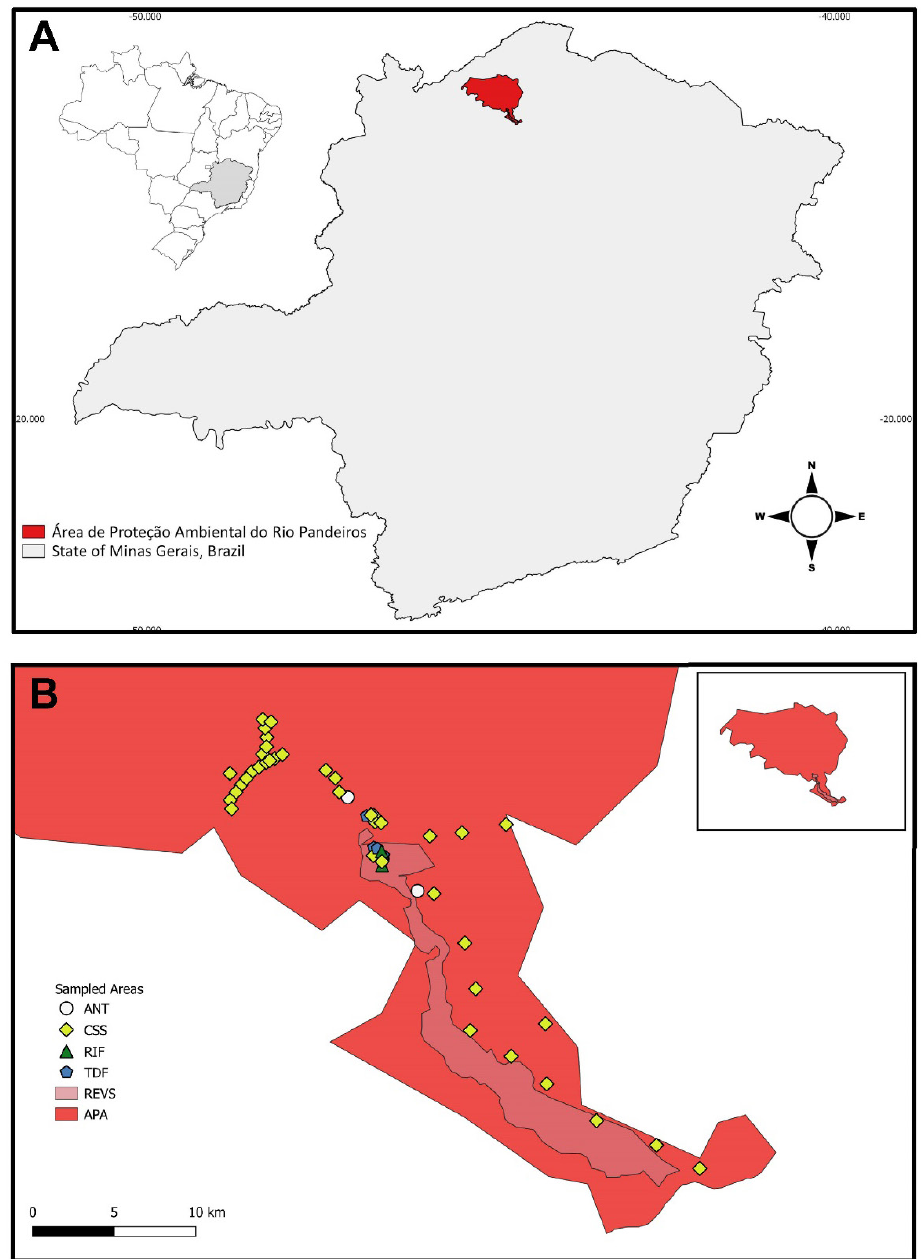
Fig 1 . Map of Minas Gerais state (gray), in Brazil, with Área de Proteção Ambiental do Rio Pandeiros – APA Pandeiros (red) (A). Map of APA Pandeiros in (red) and REVS do Rio Pandeiros (pink), Riparian Forest (RIF, represented by green triangles), Anthropogenic habitats (ANT, represented by white dots), Tropical Dry Forest (TDF, represented by blue pentagons), and Cerrado sensu stricto (CSS, represented by yellow diamonds) sampled areas